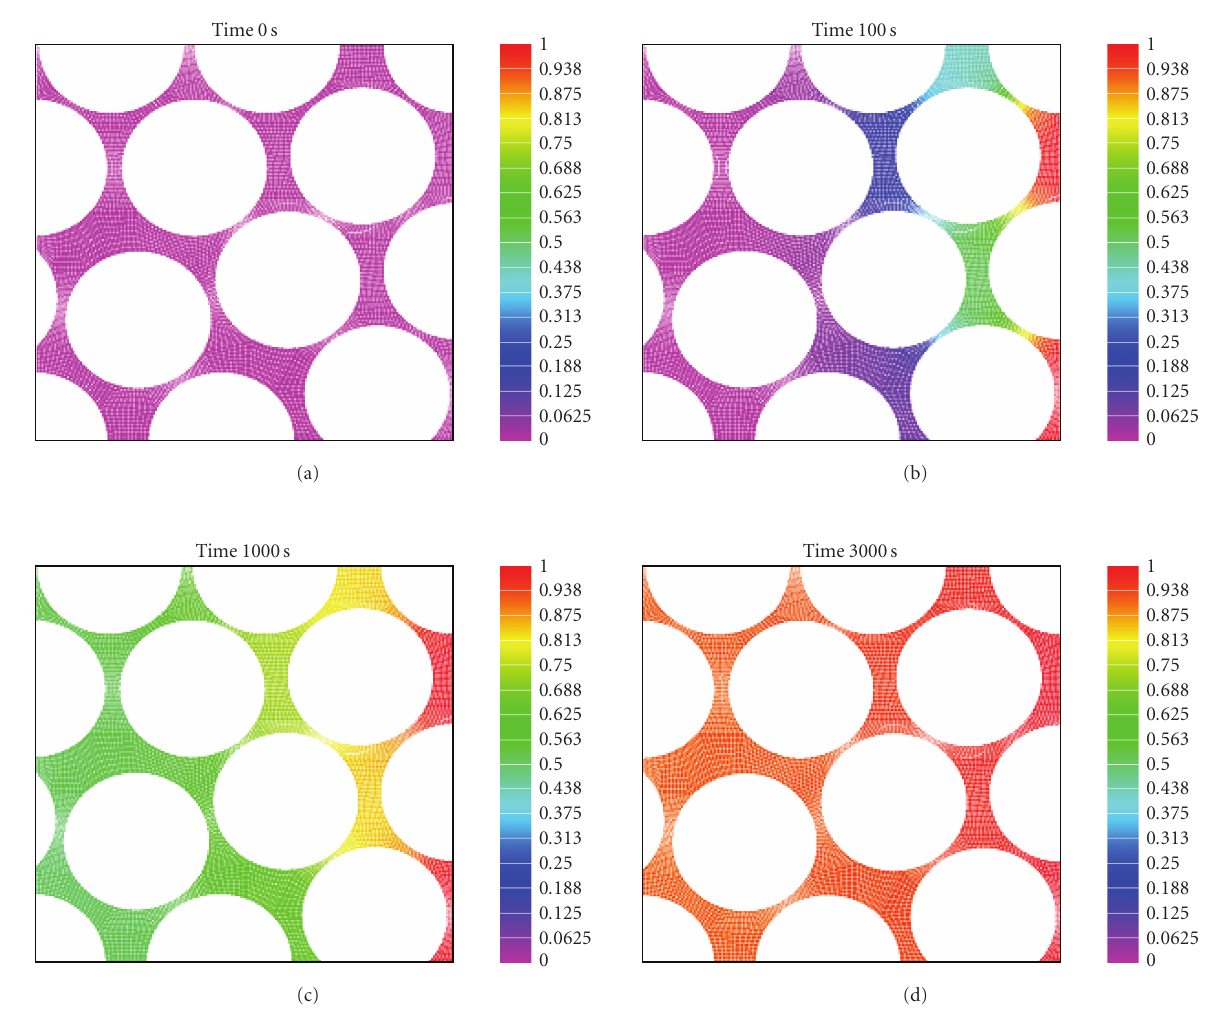
Figure 11: Simulation of the di ff usion process of a bundle RUC. The image shows the simulation at four di ff erent time steps: 0 second, 100 seconds, 1000 seconds, and 3000 seconds. It is assumed that the transitory regime ends at 3000 seconds. The di ff erent colors represent the di ff erent moisture concentration normalized with respect to the moisture concentration at equilibrium.